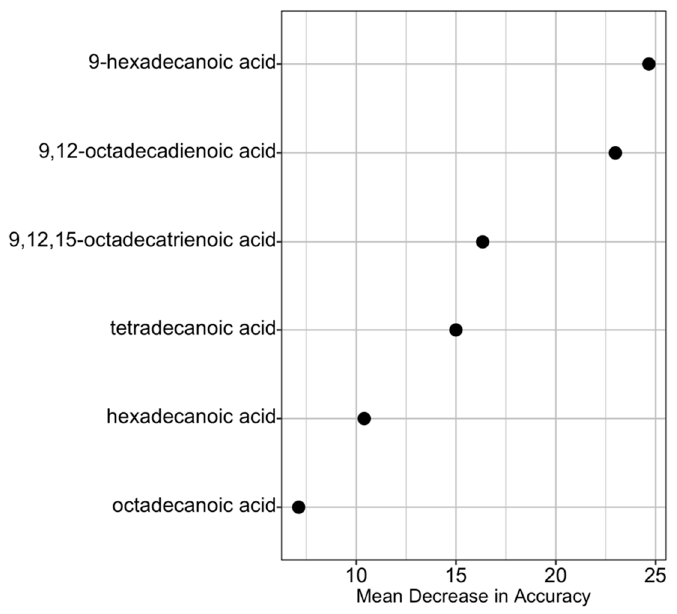
Figure 3. Ranked importance of the fatty acids in the random forests model using Gini Index.